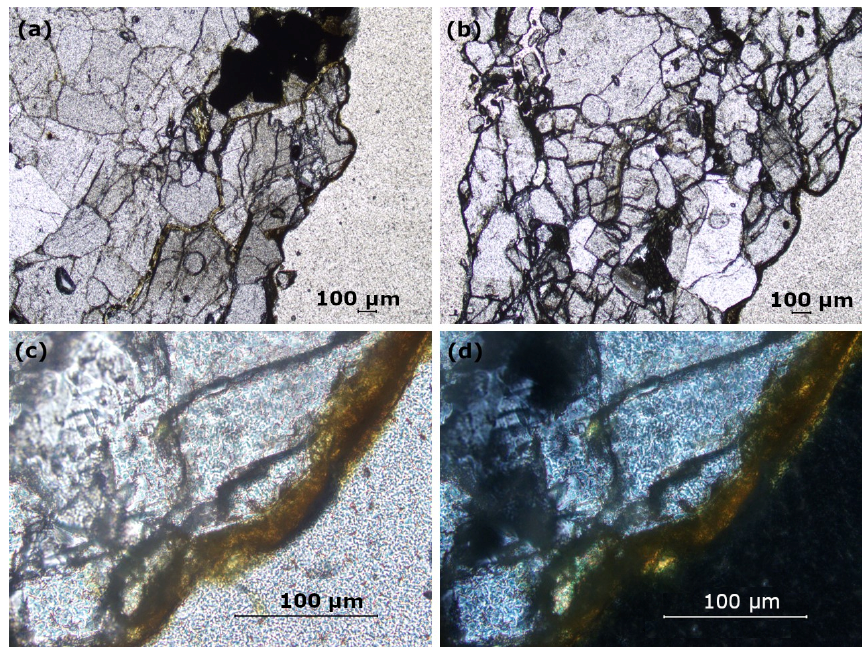
Figure 2. ( a ) Plane-polarized light (PPL) microscopic image showing black coating growing on the lithic surface of sample 1 and extending into cracks, the iron inclusion is black; ( b ) PPL microscopic image showing black coating growing on the lithic surface of sample 2; ( c ) higher magnification of the coating from sample 1 in PPL and ( d ) in cross-polarized light (XPL).